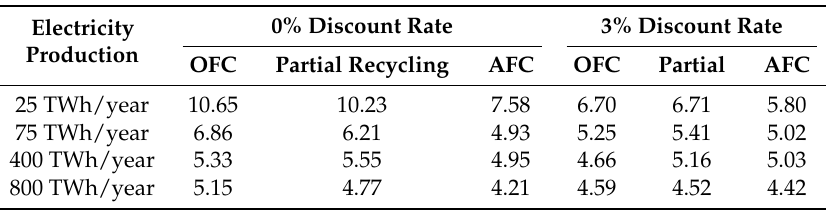
Table 5. LCOE for different back-end strategies in $(2010)/MWh.